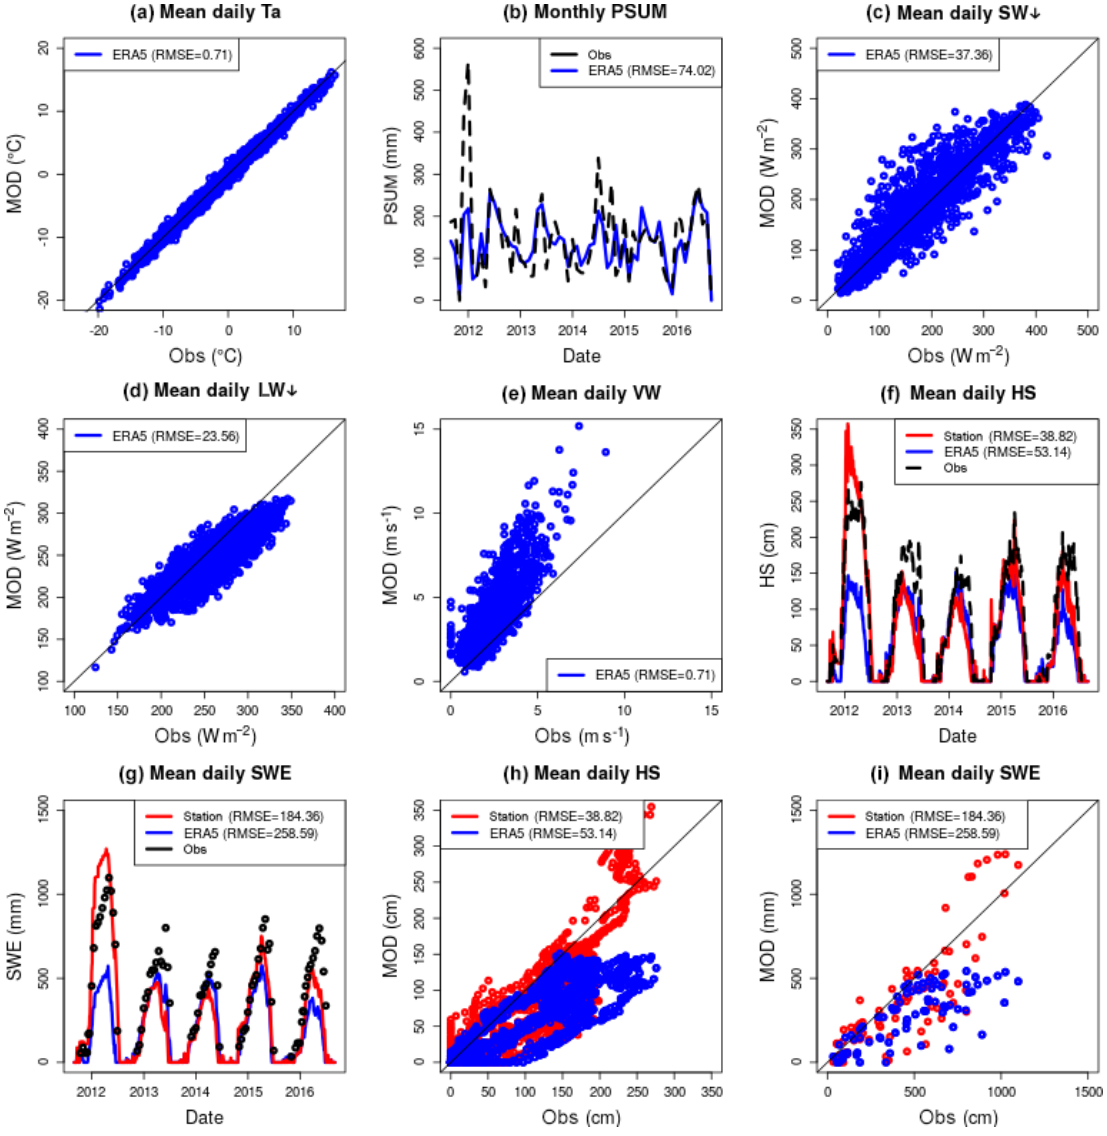
Figure 3. Multiyear simulations at the WFJ station (WY2012–2017) in order to show baseline results for the modelling scheme. Panels (a) – (e) assess the downscaling scheme by showing downscaled ERA5 data (ERA5) compared to station measurements (Obs). Panels (f) – (i) assess the simulation of target variables, SWE and HS, in both time series and scatter plots. Here, ERA5 is a simulation driven either by downscaled ERA5 (ERA5) or directly by station measurements (Station). Obs are SWE and HS measurements made at the station. WY2012 is a clear outlier in poor performing ERA5 as shown by cumulative precipitation errors and in the HS and SWE time series. The HS and SWE scatter plots also show this low performance in high values attributed to WY2012. Additionally, ERA5-simulated HS is increasingly biased with depth as errors accumulate over the season to maximum depth values. The same pattern is evident for SWE. It is worth noting that these plots are useful in differentiating sources of error. Obs minus Station approximates model error, whereas Station minus ERA5 approximates the forcing